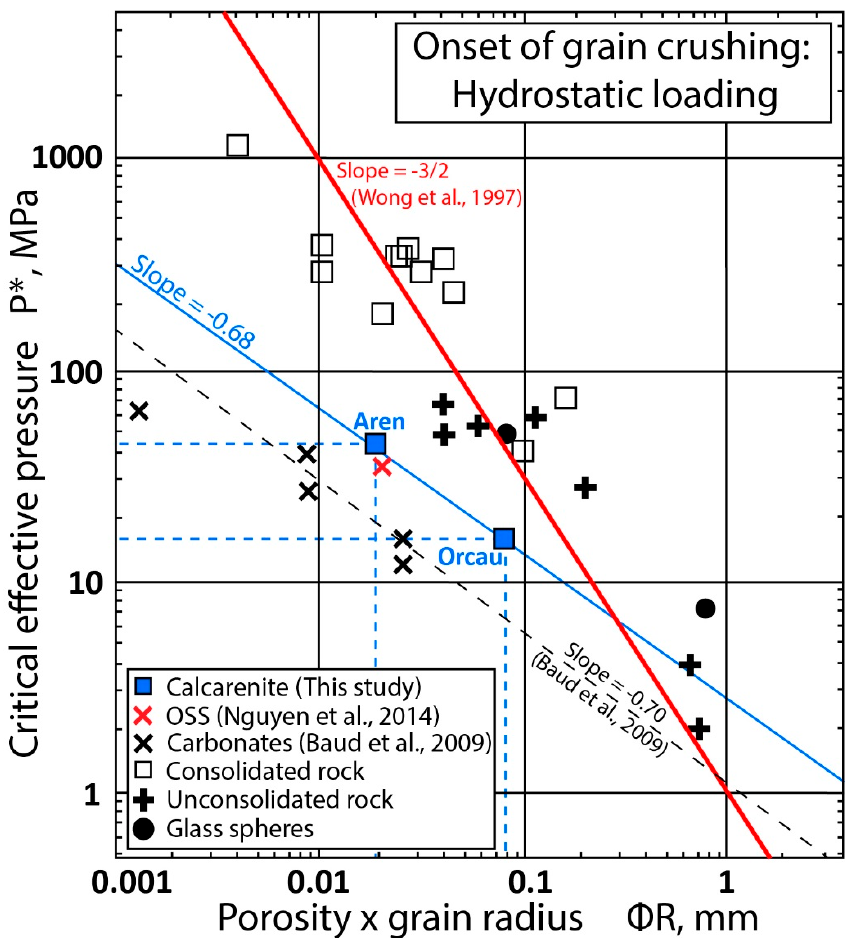
Figure 7. Diagram of critical effective pressure (P*) vs. the product of porosity and the grain radius. Results of geomechanical experiments and slope trend are plotted for siliciclastic materials [13,14], porous carbonate rocks [76], and an Otter Sherwood Sandstone (OSS, [77]). Theoretical results for the Aren calcarenite of Aren and Orcau sites are also plotted, see text for calculus details.